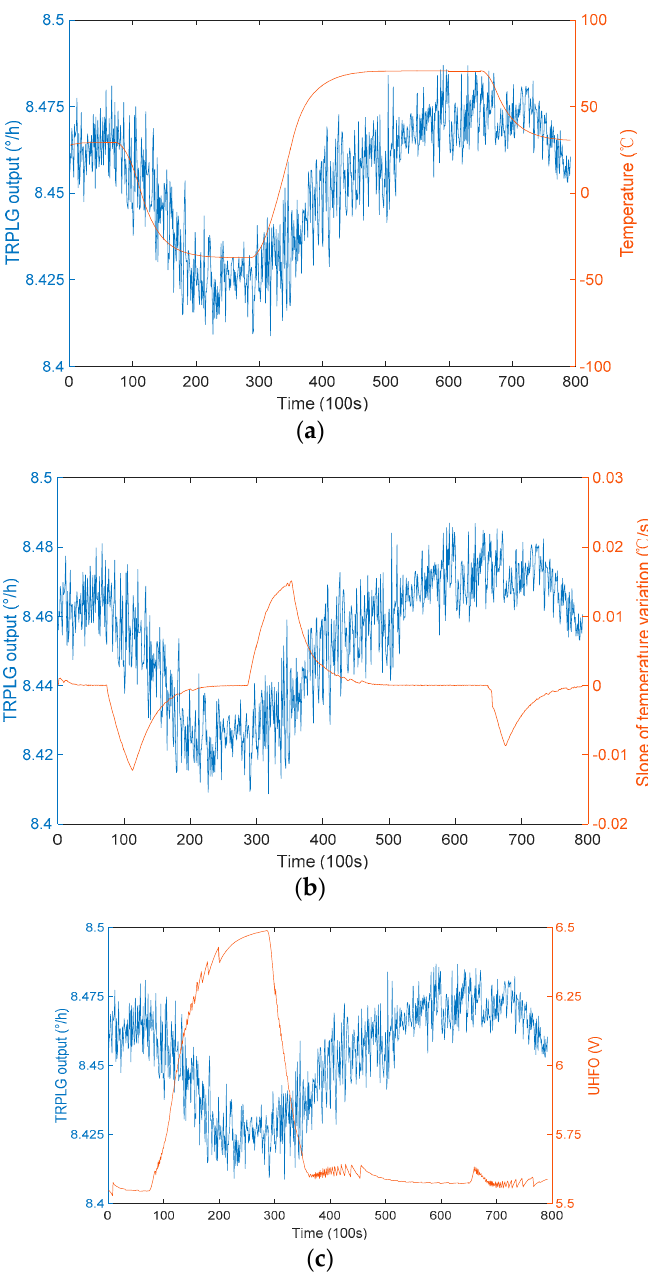
Figure 6. The relationship between the TRPLG output and different parameters: ( a ) Temperature; ( b ) Slope of temperature variation; ( c ) UHFO. Table 1. Correlation coefficient between TRPLG output and parameters.